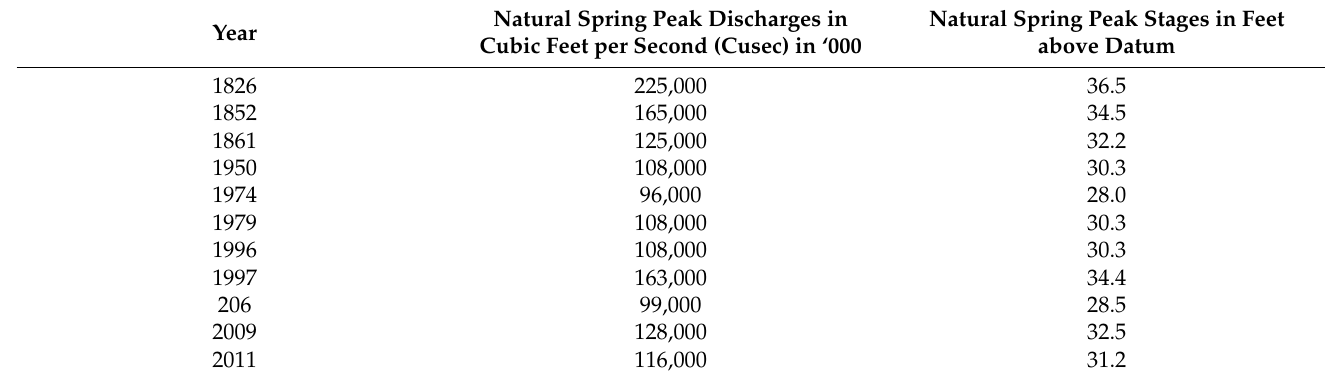
Table 1. Comparison of flood years in relation to natural spring peak discharges and natural spring peak stages measured at James Avenue, Winnipeg (the zero point of the gauge is 727.57 ft. above mean sea level) (Source of data: Manitoba Conservation and Water Stewardship, 2014). Note: 1974, 1979, 1996, 1997, 2006, 2009, and 2011 were computed without the use of Red River Floodway, Portage Diversion, and Shellmouth